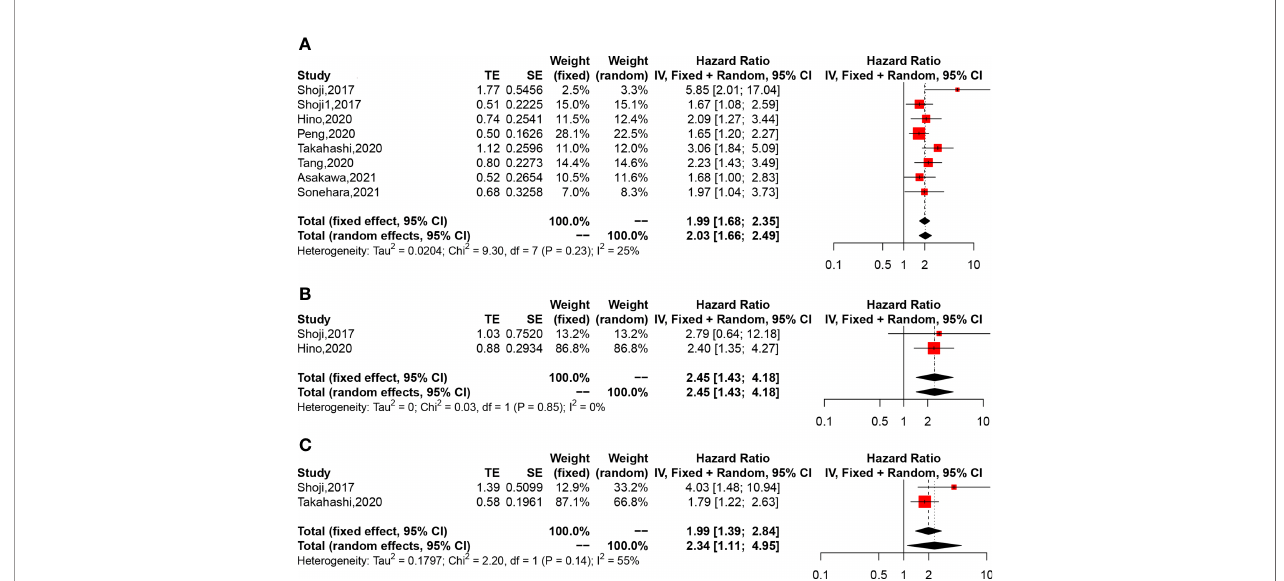
FIGURE 2 | The forest plot of the association between Geriatric Nutritional Risk Index (GNRI) and the clinical outcome of non-small cell lung cancer patients. (A) Forest plot of overall survival (OS). (B) Forest plot of cancer-speci fi c survival (CSS). (C) Forest plot of recurrence-free survival (RFS).